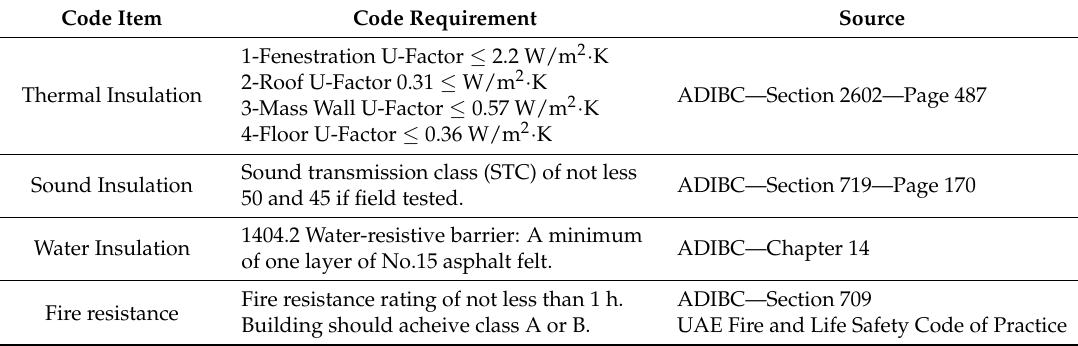
Table 1. Relevant building code requirements